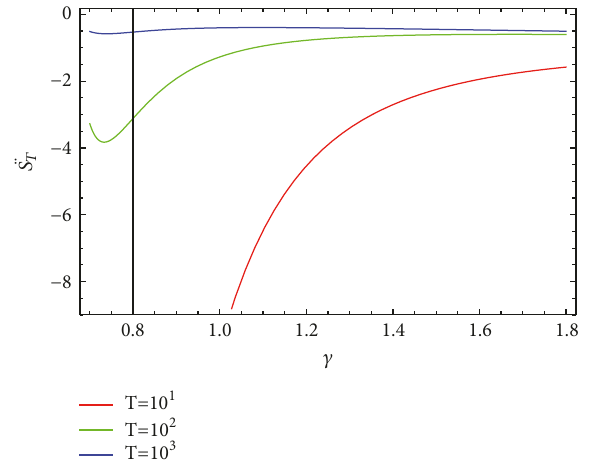
̈𝑆 𝛾 for Renyi entropy when Γ = Γ(𝑡) 𝑇 versus